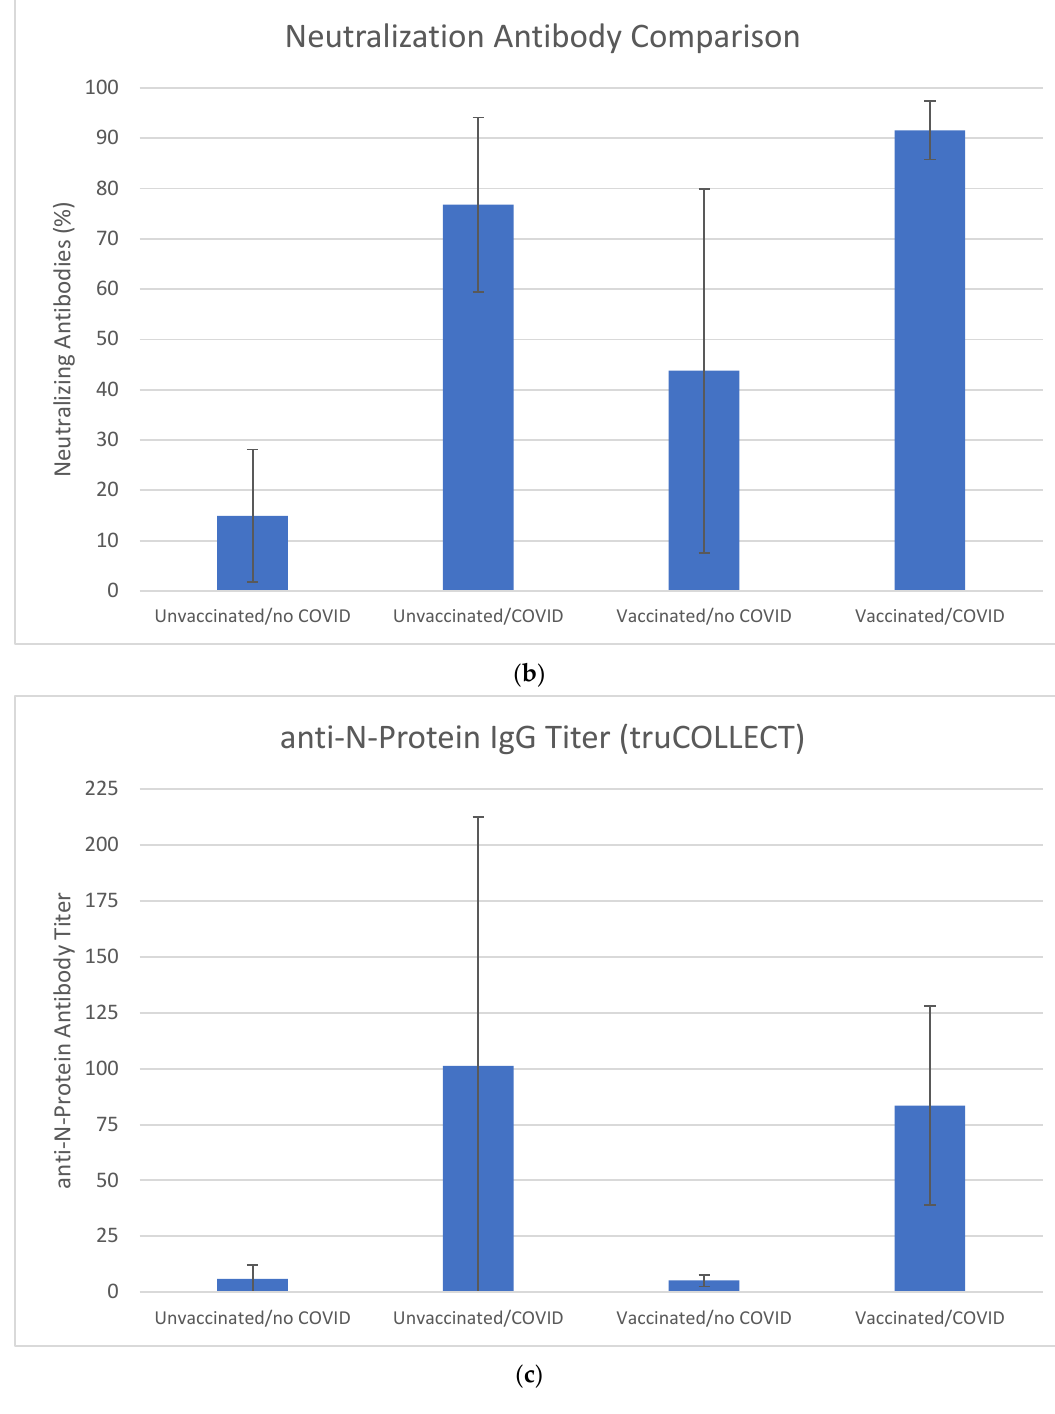
Figure 8. Antibody titers specific against S-protein ( a ), percent neutralization of S-protein antibodies ( b ), and antibody titers specific against N-protein ( c ) amongst different donor groups (truCOLLECT-derived extract data only): unvaccinated/no-COVID, unvaccinated/COVID, vaccinated/no-COVID and vaccinated/COVID. The weak correlation due to high variability of the N-protein IgG titers is apparent. However, both S-protein antibody titers and their respective percent neutralization levels promise to offer better potential to predict past COVID-infections.